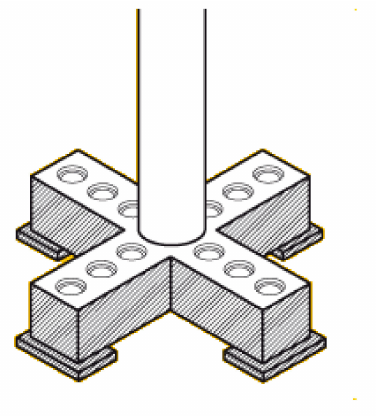
Figure 9. Züblin gravity